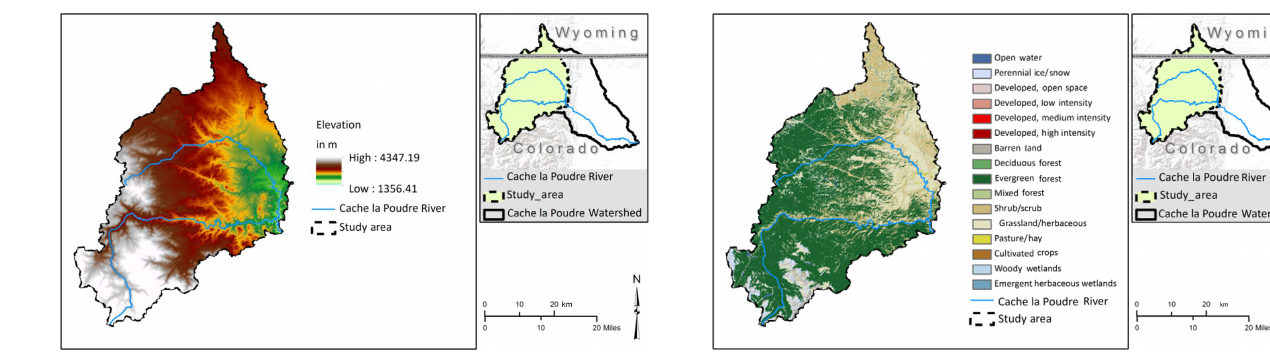
Figure A1. Distribution of elevation within the study watershed based on the 10m DEM.